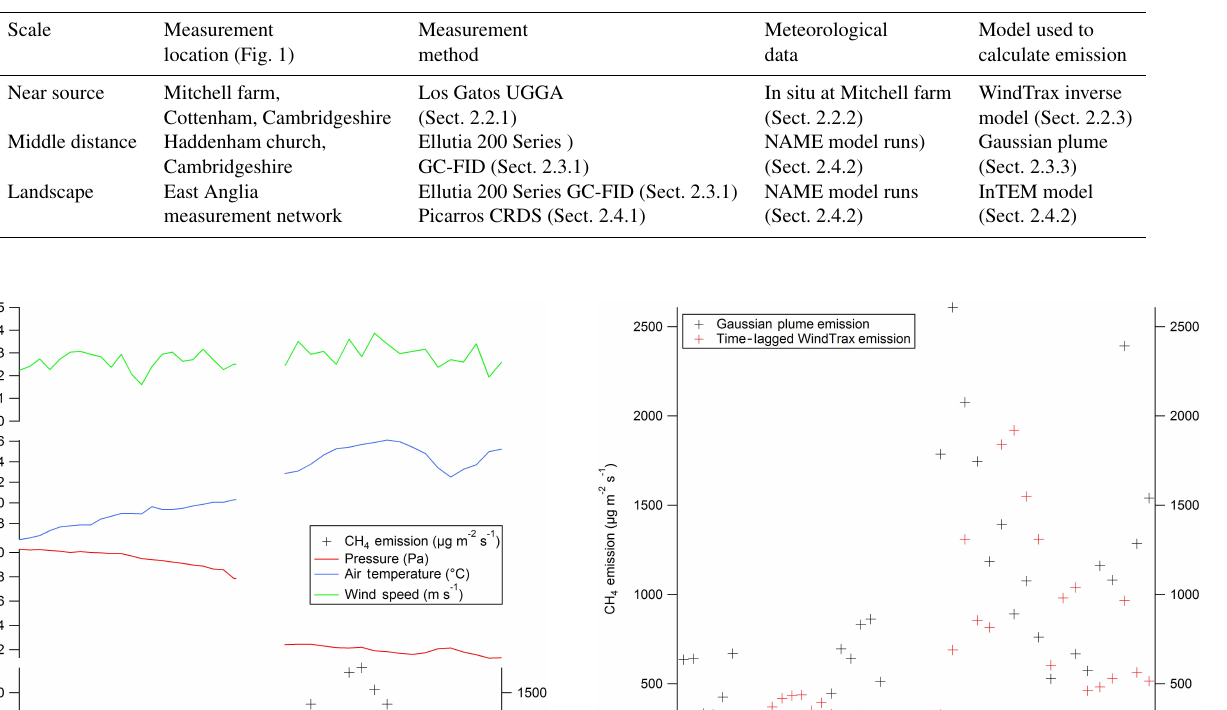
Table 1. Summary of methods used to calculate methane emission estimates from a landfill at different scales: near source, middle distance and landscape.